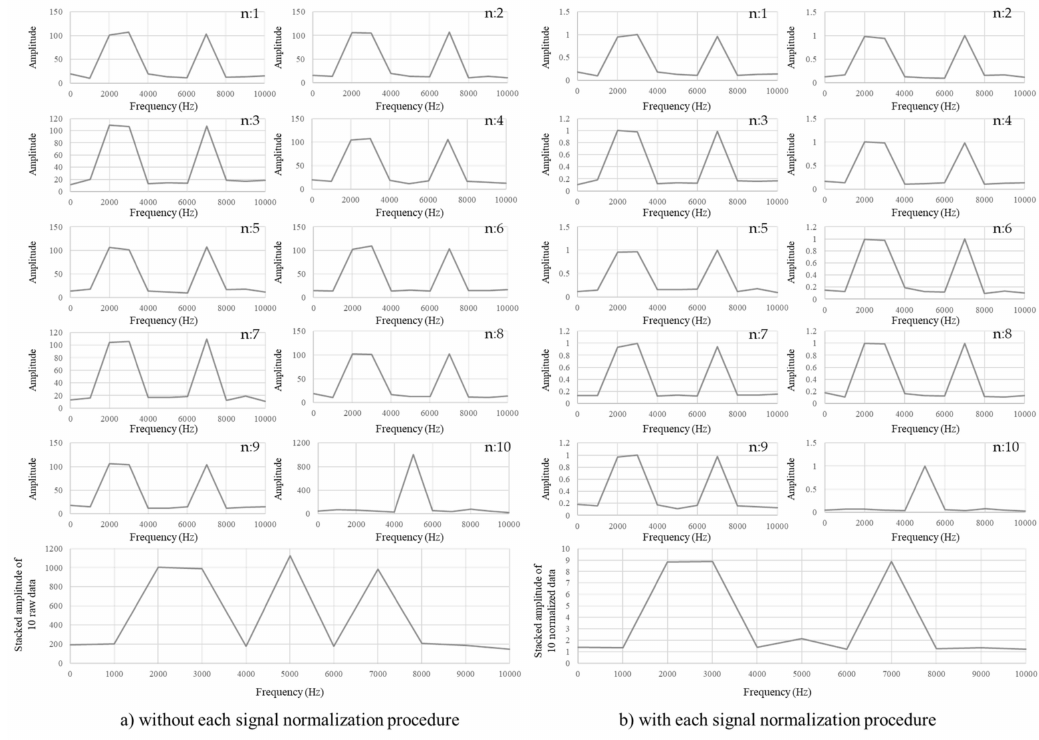
Figure 8. FFT signal data stacking procedure with / without each signal normalization procedure.